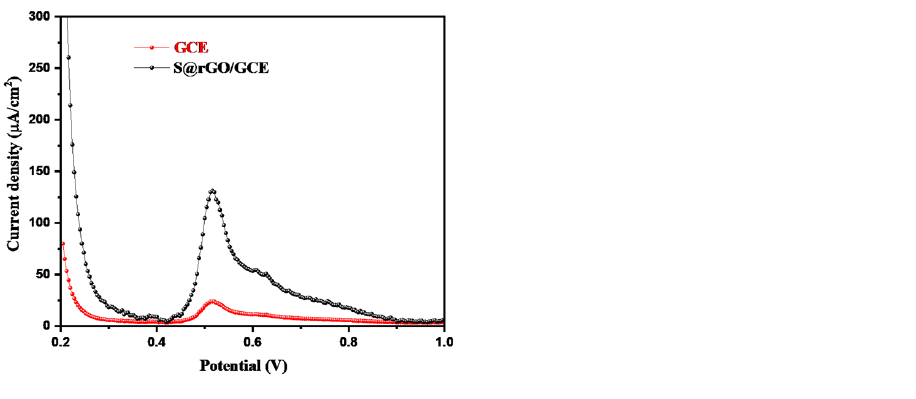
Figure 7. DPV pattern of GCE and S@rGO/GCE in presence of 125 µM acetaminophen in 0.1 M PBS (pH = 7.0; scan rate = 50 mV/s).